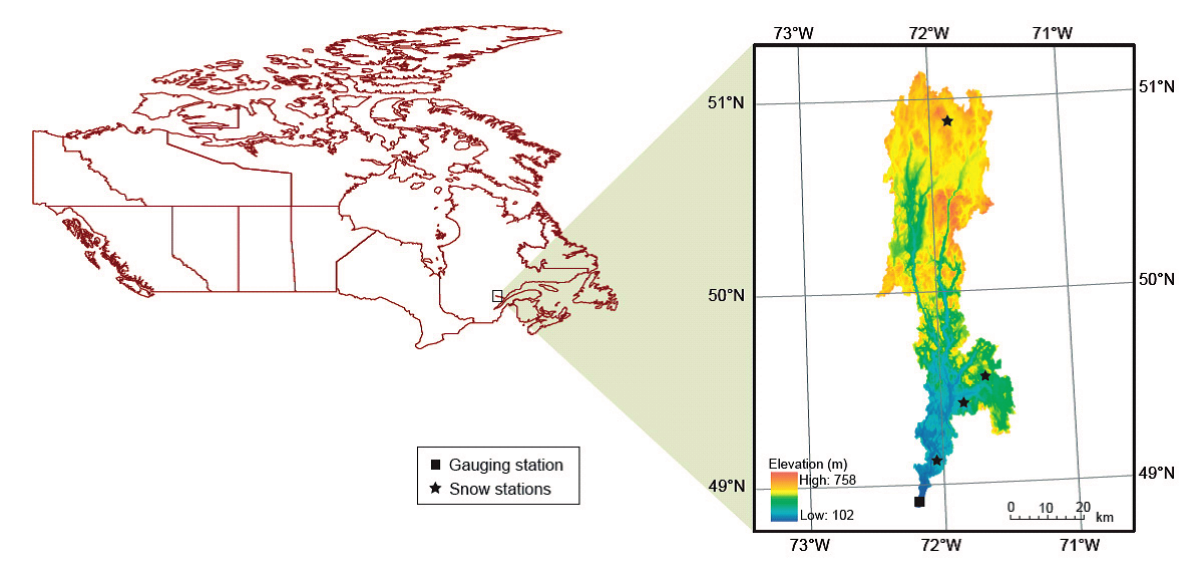
Figure 1. Location map of the Mistassibi